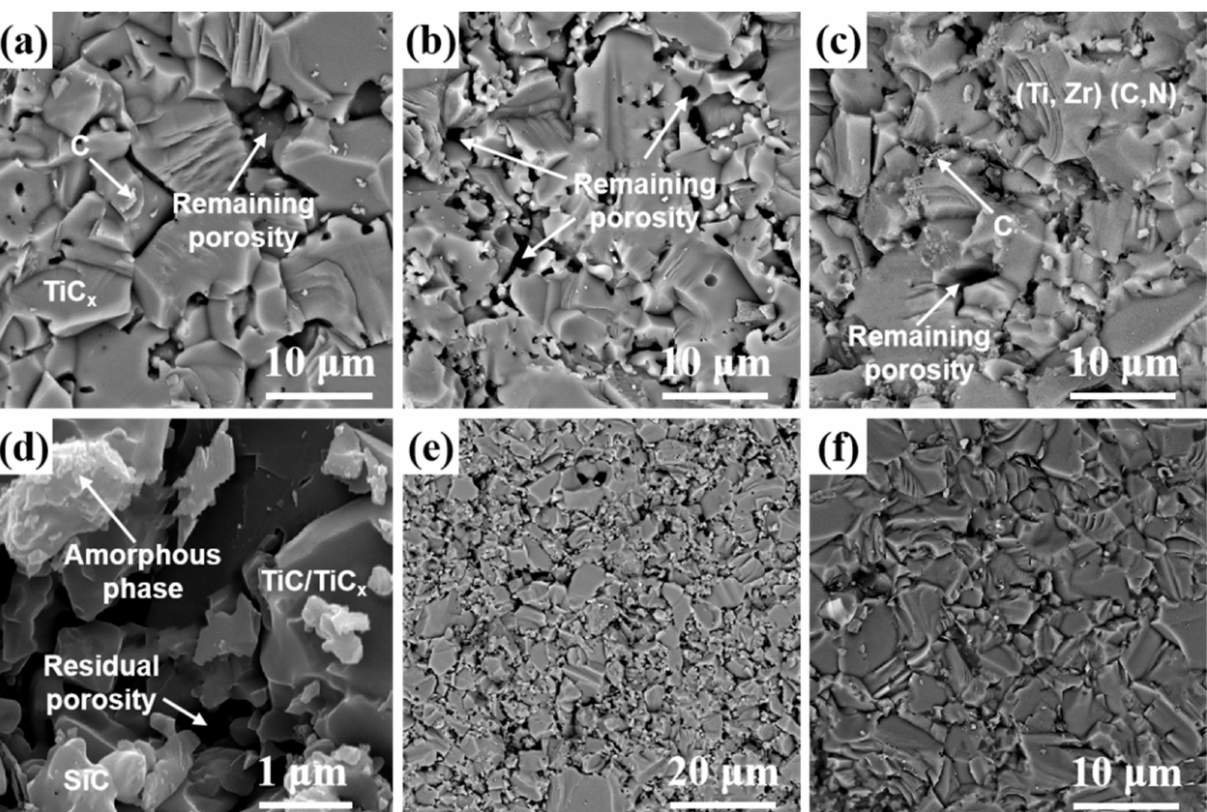
Figure 7. Fracture morphologies of TiC ( a ), TiC-5 wt.% ZrN ( b ), TiC-5 wt.% ZrN-5 wt.% C ( c ), TiC-5 wt.% Si 3 N 4 ( d ), TiC-5 wt.% TiN ( e ), and TiC-5 wt.% AlN ( f